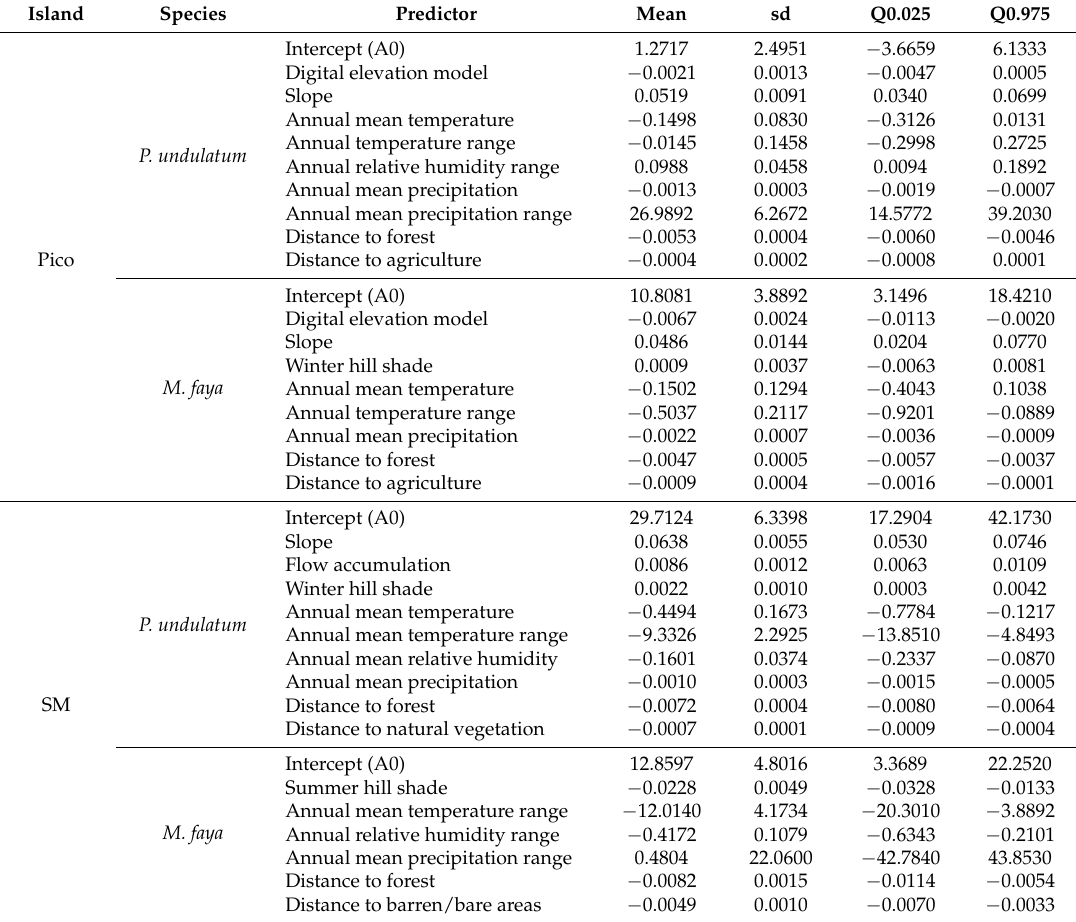
Table 7. Numerical summary of the posterior distributions of the parameters for the best mixed effects model for the two species studied and islands. This summary contains the mean, the standard deviation (sd), and 95% credibility interval. SM: S ã o Miguel.